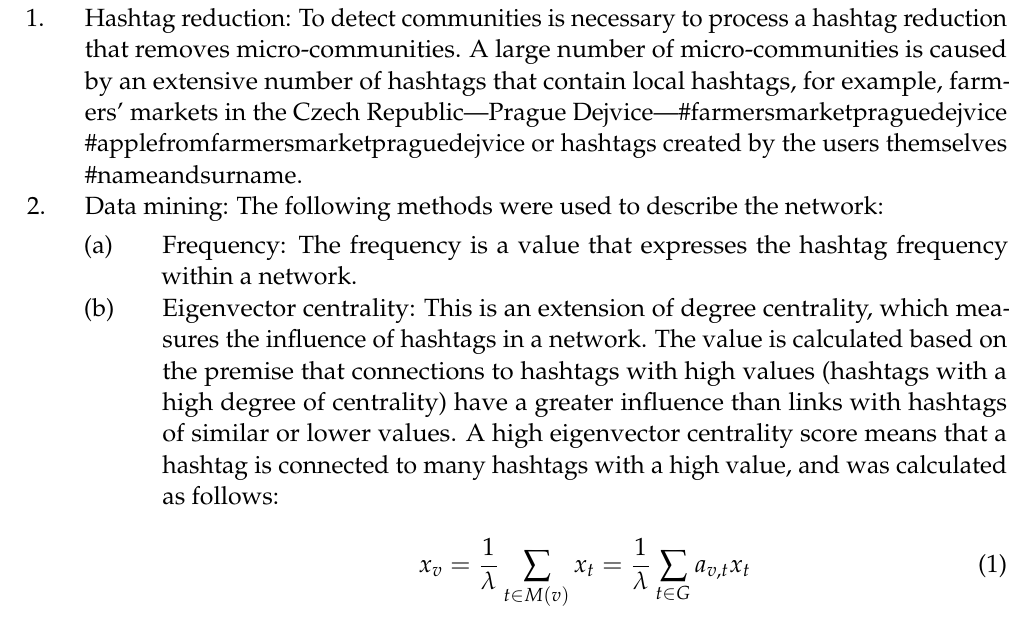
Figure 2. Transformation from the Twitter social network into a hashtag